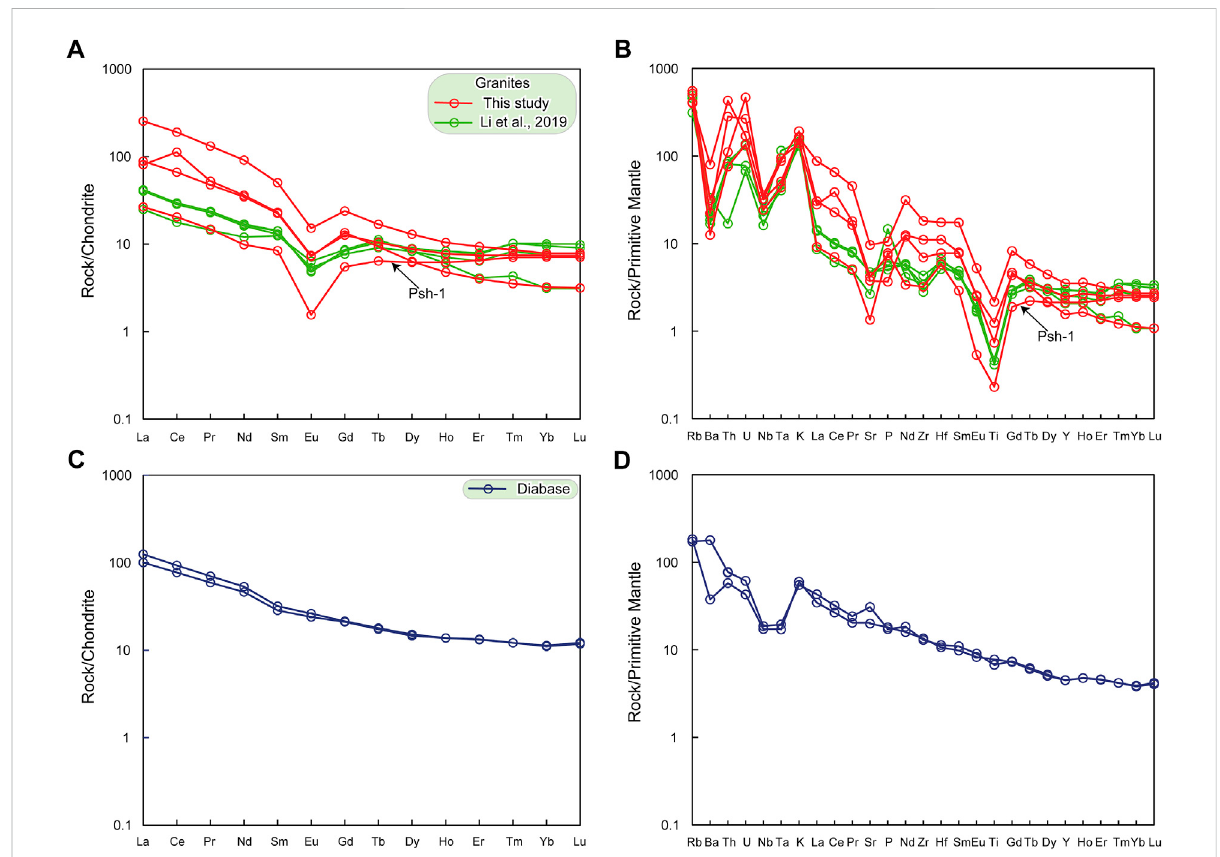
FIGURE 6 Chondrite-normalized REE and primitive-mantle normalized trace element multi-variation diagrams of granitic (A,B) and diabase (C,D) rocks. The mantle-normalization and chondrite values are from Sun and McDonough (1989).